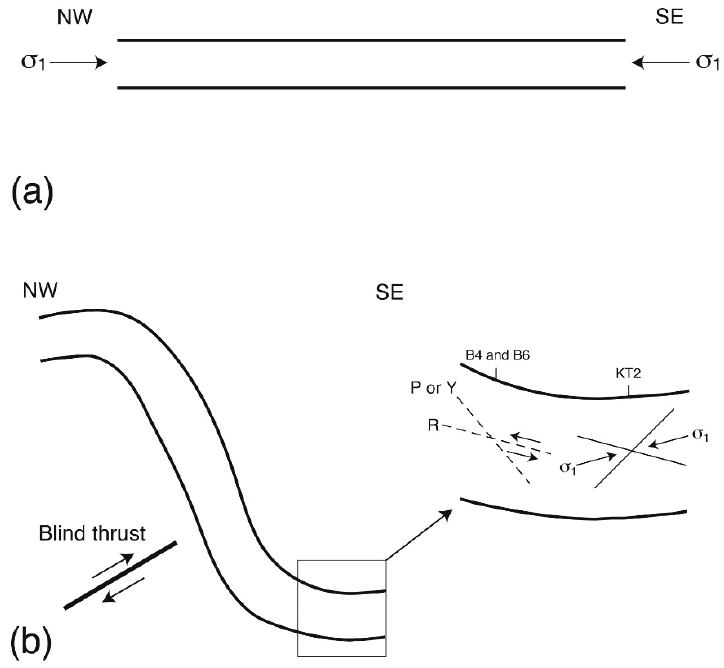
Figure 15. Schematic diagram showing a model of development of the flexure and deformation bands. See text for explanations. ( a ) Before folding. ( b ) After folding. Note that the conjugate deformation bands in outcrop sample KT2 (Figure 7b,c) are flipped so that the σ 1 orientation is conformable to activate the bedding parallel R-bands in the B4 and B6 core samples. This is an explanation because not only the sample KT2 was not collected as an oriented sample, but also the borehole cores B4 and B6 were not